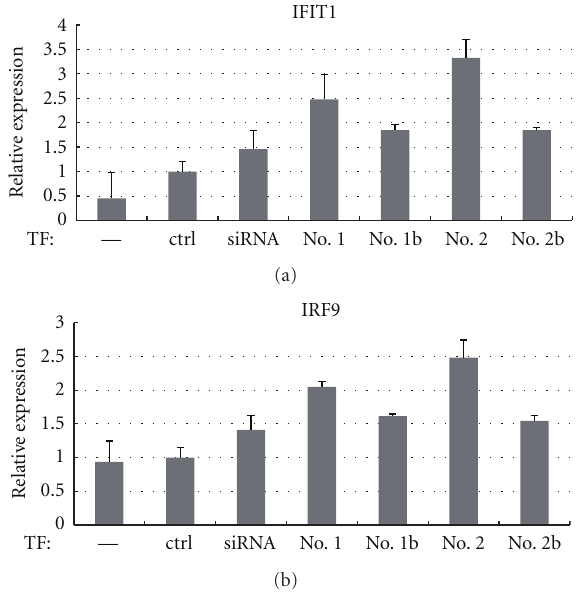
Figure 4: Interferon responses induced by synthetic shRNAs. HeLa cells were transfected with the indicated RNAs. After 48 h, the expression of two interferon-regulated genes IFIT1 and IRF9 was analyzed by